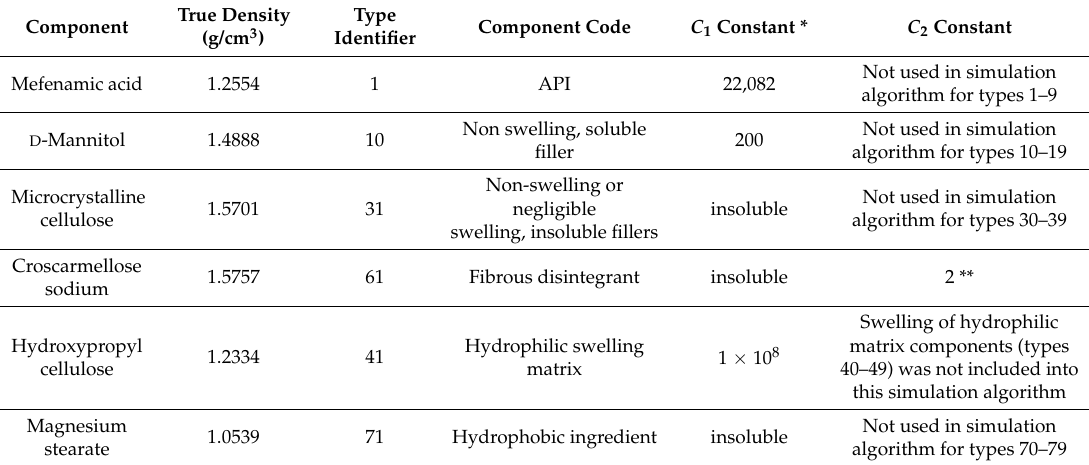
Table 2. Summary of the parameters used for the in silico dissolution